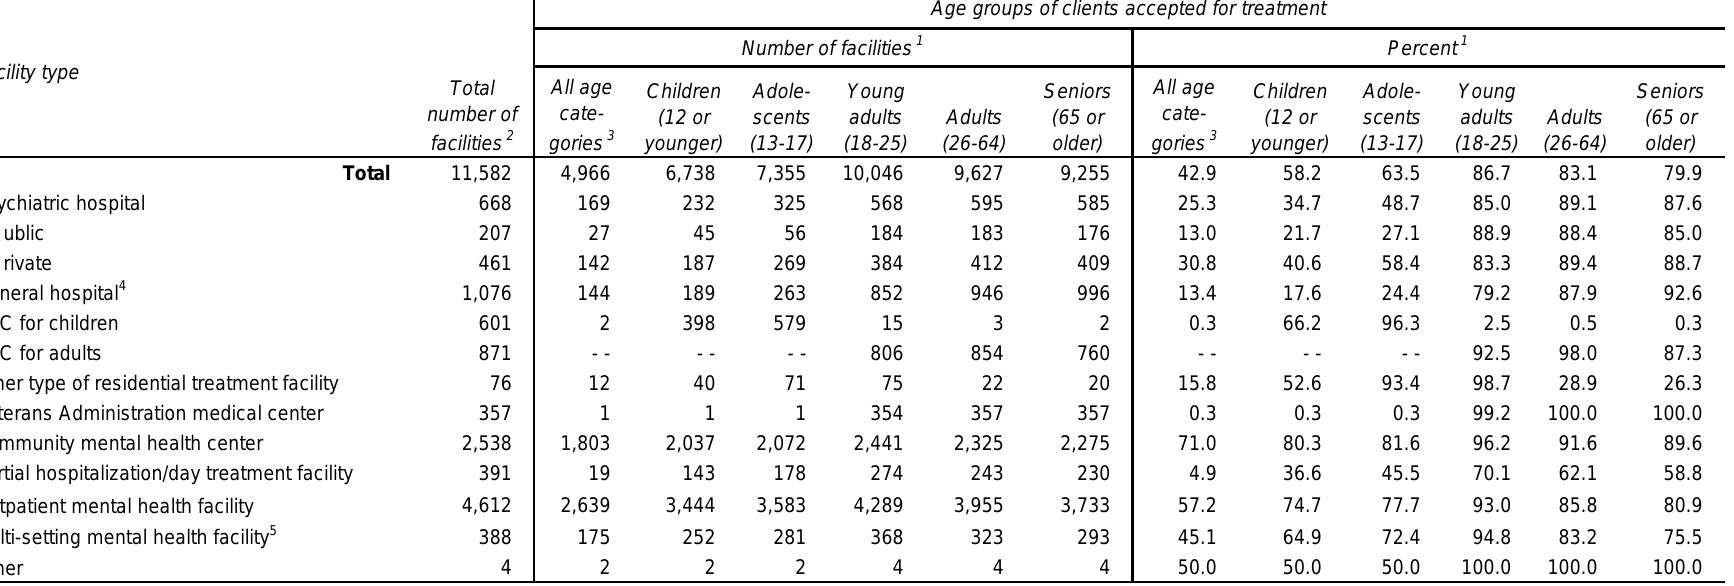
Table 2.5. Mental health treatment facilities accepting specific age groups for treatment, by facility type: Number and percent,